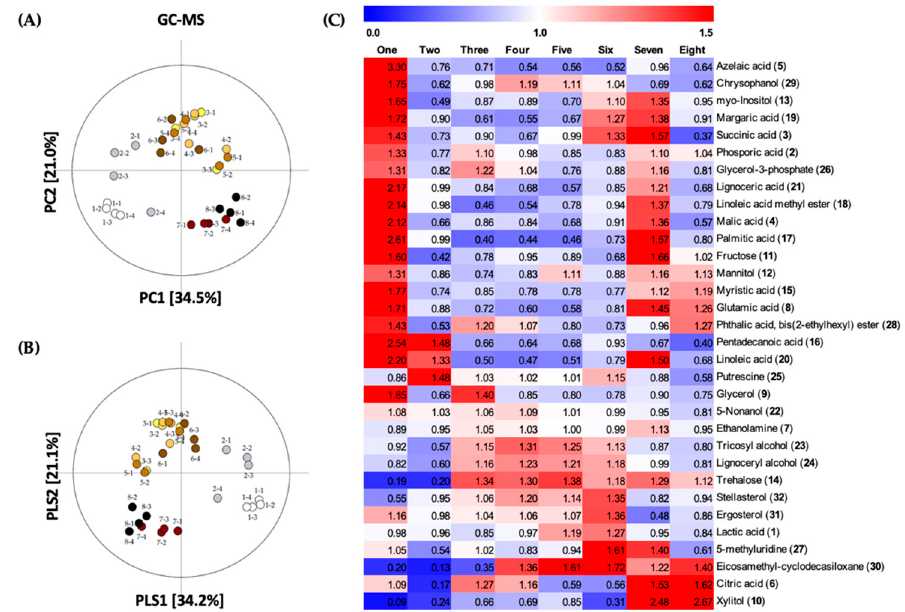
Figure 2. ( A ) PCA score plot and ( B ) PLS-DA score plot of each G. lingzhi samples at the eight developmental stages analyzed by GC/MS; ( C ) Heat maps of significantly different metabolites at the eight developmental stages of G. lingzhi from GC/MS analysis. Each column represents the developmental stage, and the fold change of average peak area denoted by the number and color of heat scale.